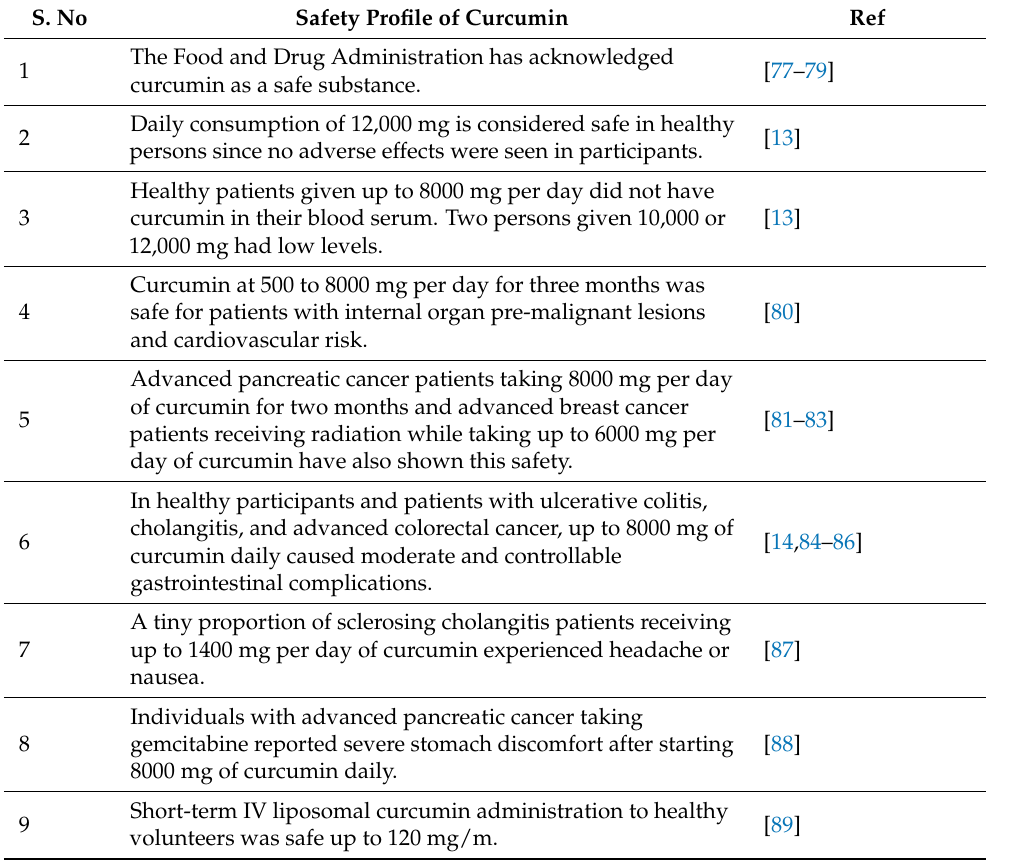
Table 3. Safety Profile of